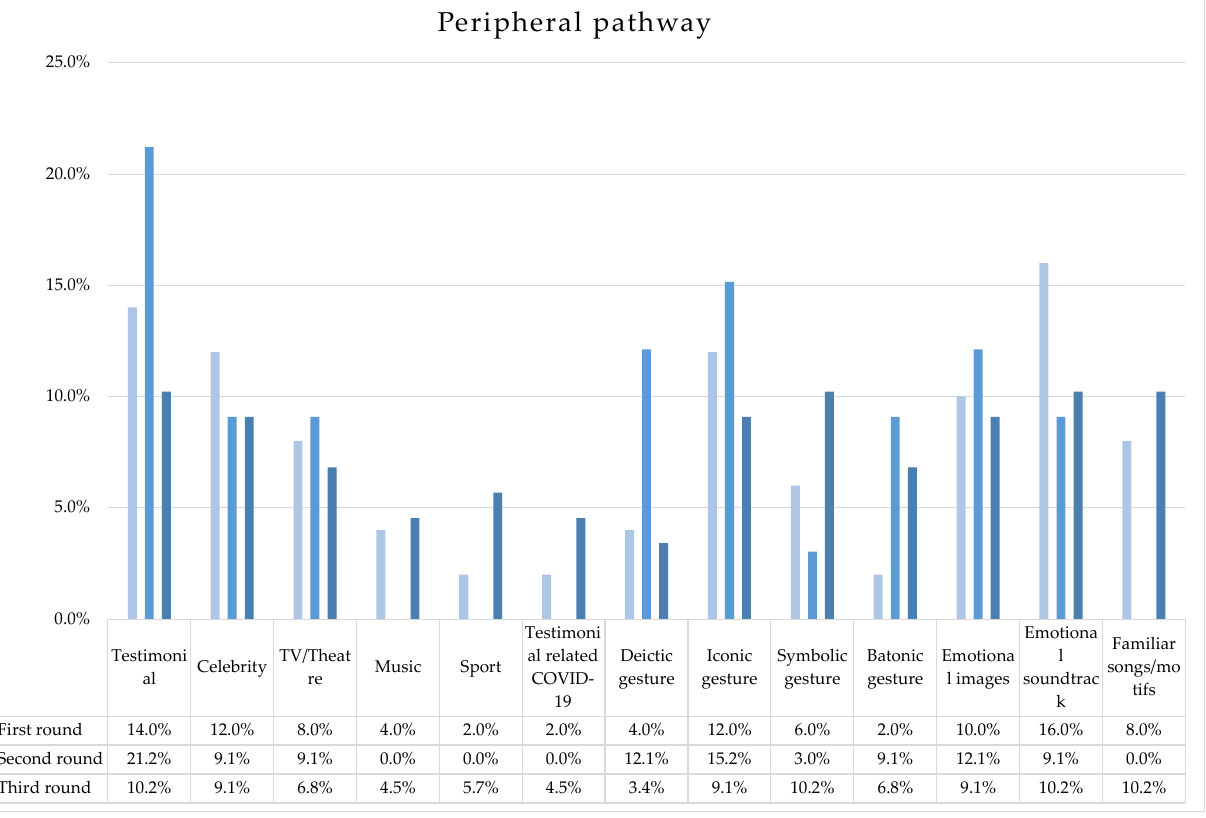
Figure 3. Percentage distribution of spots for each peripheral cue across the three rounds of the Italian institutional health campaign during COVID-19 pandemic.